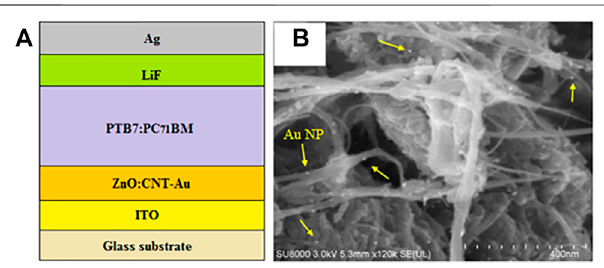
FIGURE 10 | (A) Schematic diagram of a conventional BHJ-OSC with a ZnO:CNTs-Au composite ETL and (B) SEM micrograph of the CNTs-Au fi lm. Adapted with permission (Hu et al., 2016). Copyright 2016, Elsevier.